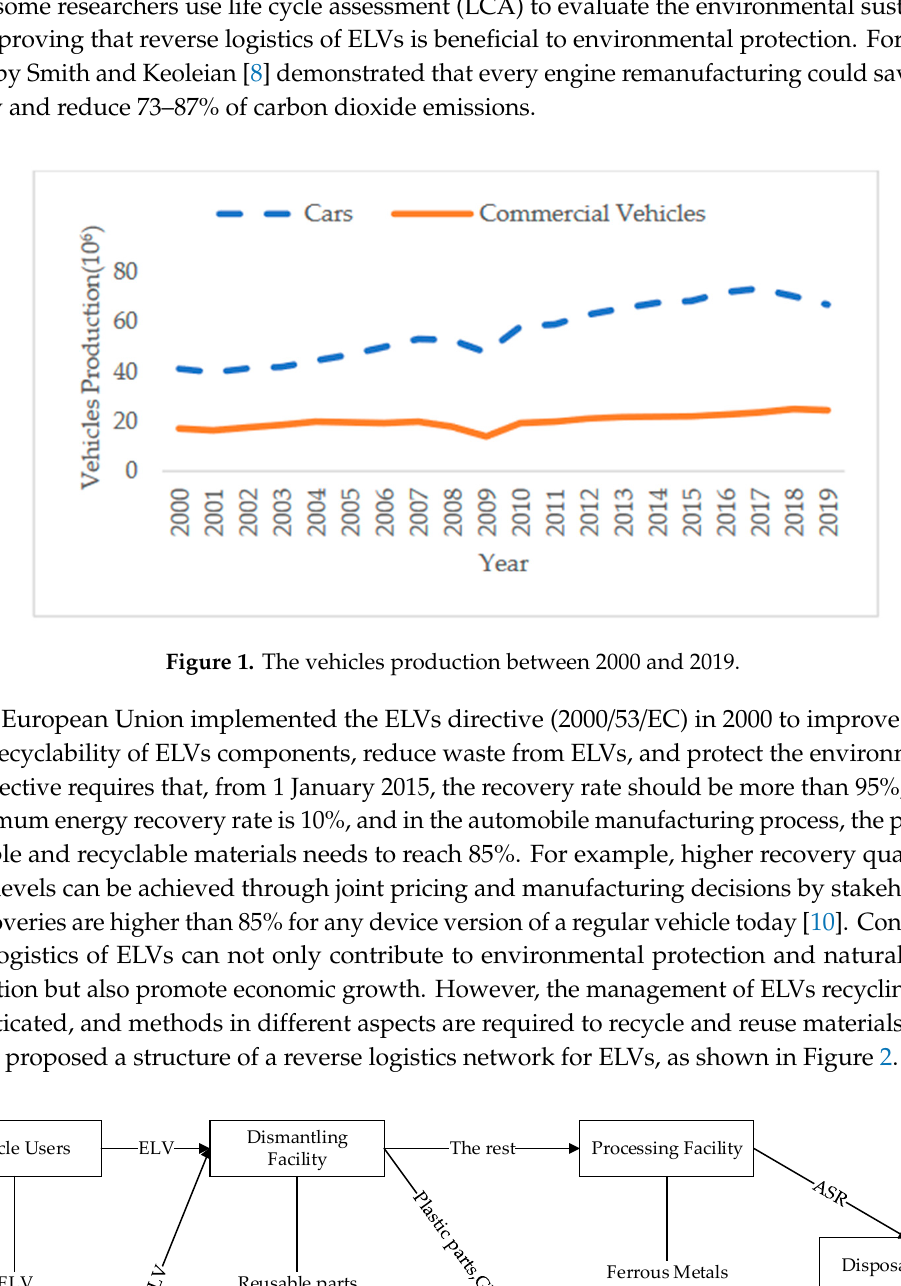
Figure 2. The reverse logistics process of end-of-life vehicles (ELVs) [11].